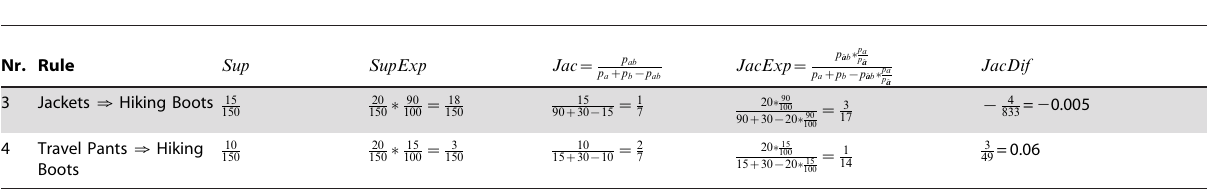
Table 3. Hierarchical Measures JacDif and SupExp